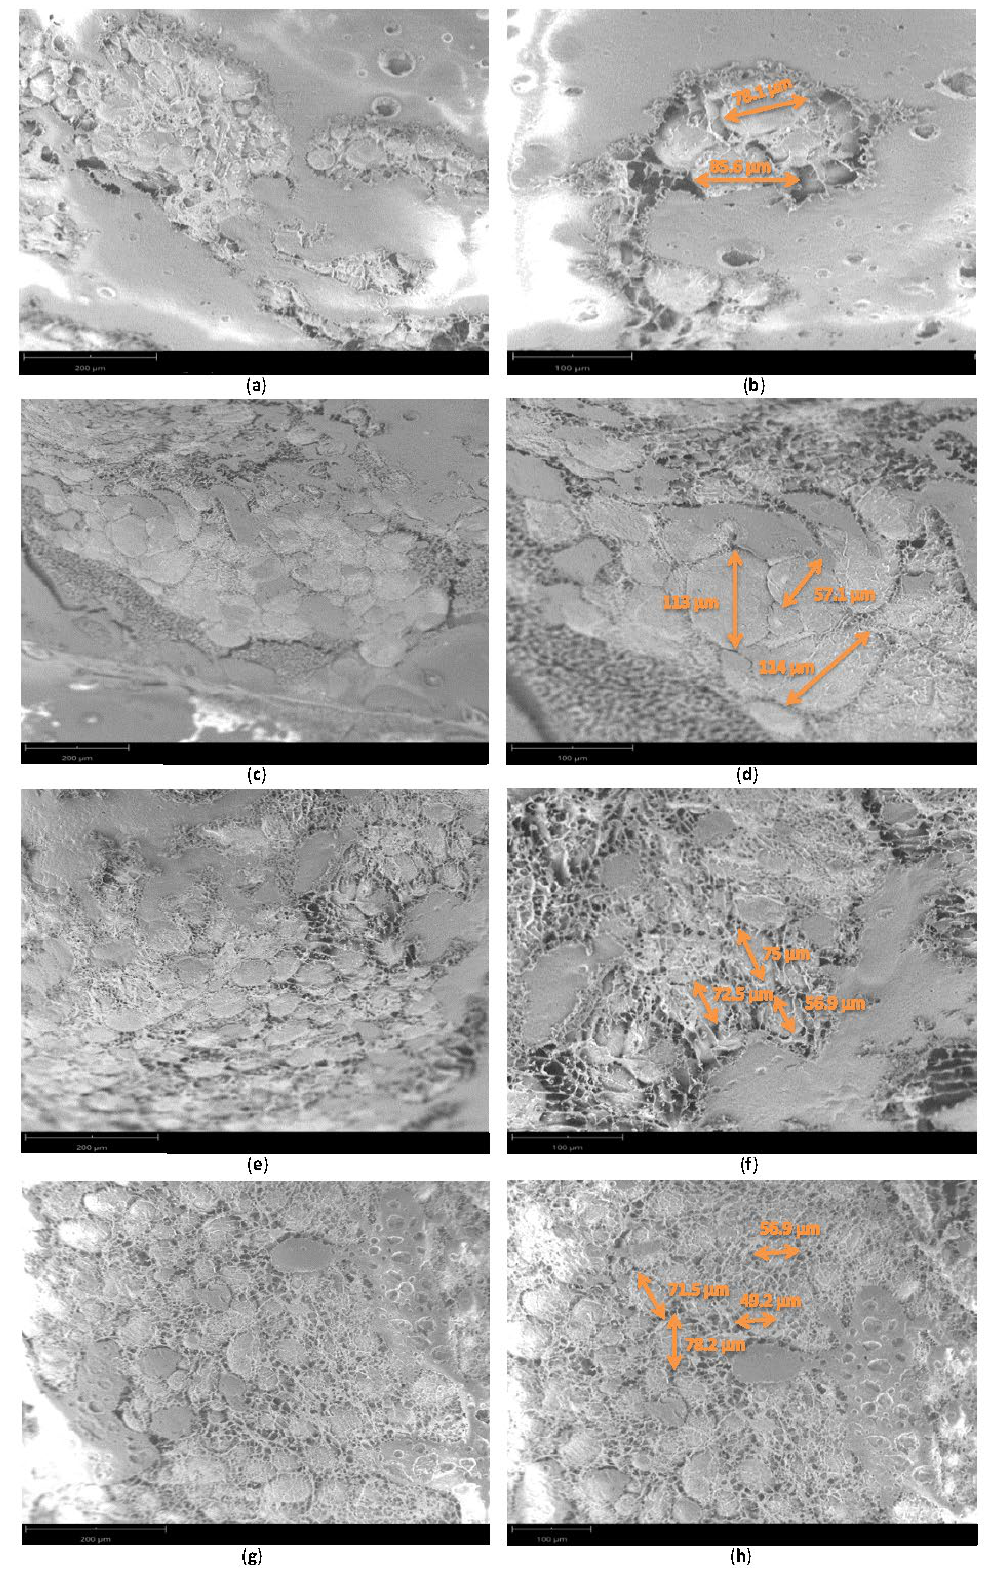
Figure 6. Scanning-electron-microscopy image of white adipose tissue. Control group ( a , b ). Selenite group ( c , d ). Low-selenite-nanoparticle group ( e , f ). Moderate-selenite-nanoparticle group ( g , h